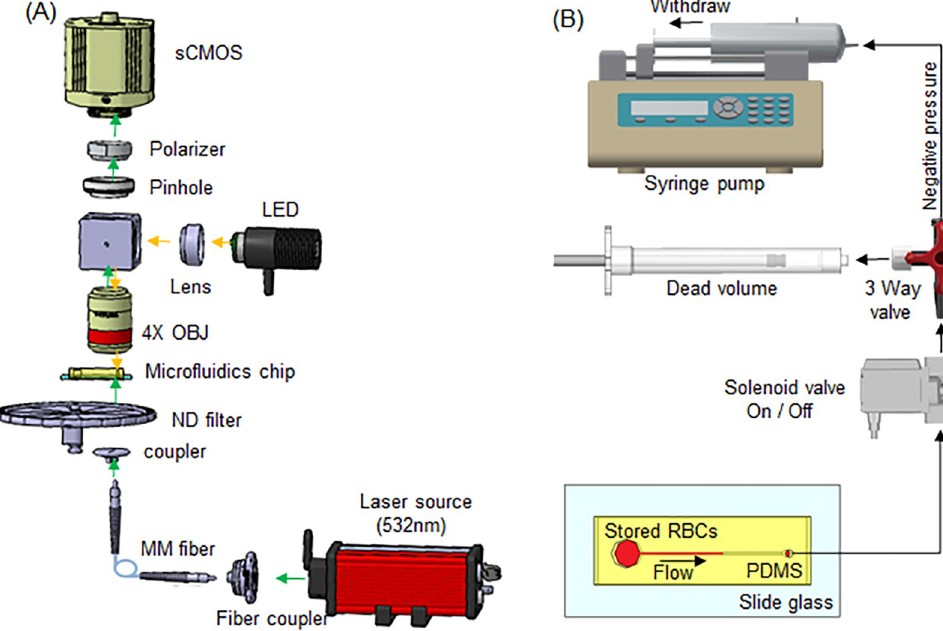
Fig 1. Setup for measurement of RBC decorrelation time with a microfluidic channel system for stored RBCs. (A) Optical experimental setup used to capture speckle intensity fluctuation; (B) Microfluidic system for flowing RBCs through a transparent microchannel comprising a microfluidics chip and vacuum flow generation. (LED: Light emitting diode, MM fiber: multimode fiber, ND filter: Neutral density filter, OBJ: Objective lens, PDMS: Polydimethylsiloxane).